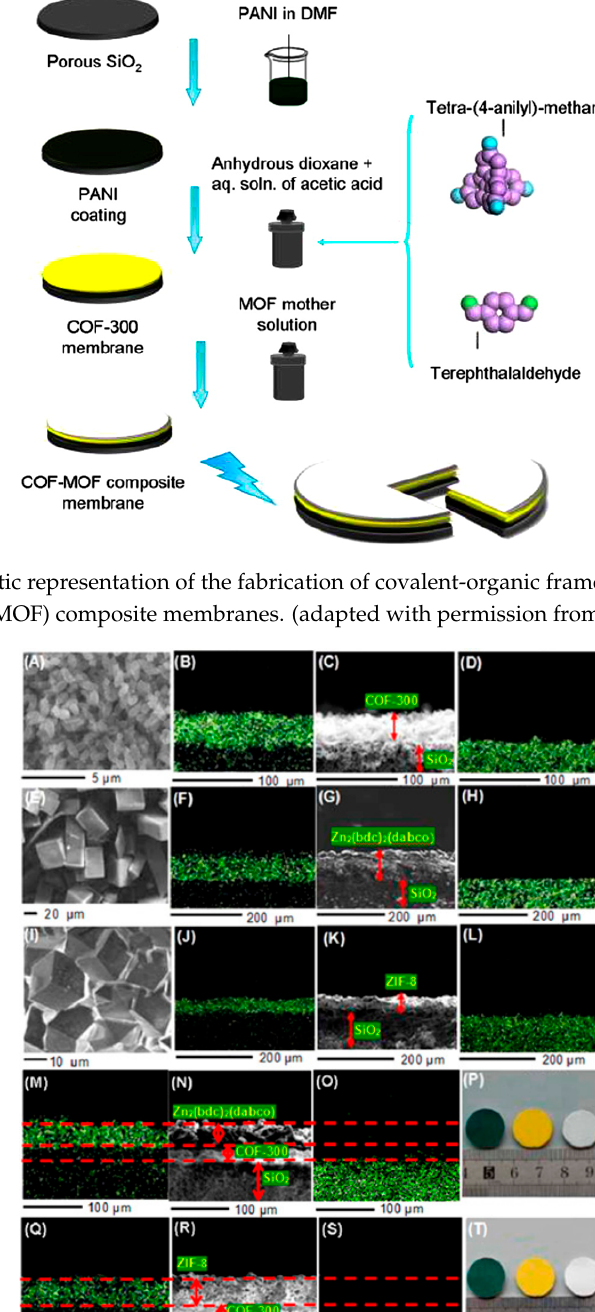
Figure 44. ( left ) Single gas permeability of various gases through the COF-300 membrane, Zn 2 (bdc) 2 (dabco) membrane, and [COF-300]-[Zn 2 (bdc) 2 (dabco)] composite membrane at room temperature and 1 bar as a function of their kinetic diameters. ( right ) Single gas permeability of various gases through the COF-300 membrane, ZIF-8 membrane, and [COF-300]-[ZIF-8] composite membrane at room temperature and 1 bar as a function of their kinetic diameters. (adapted with permission from ref. [137]).